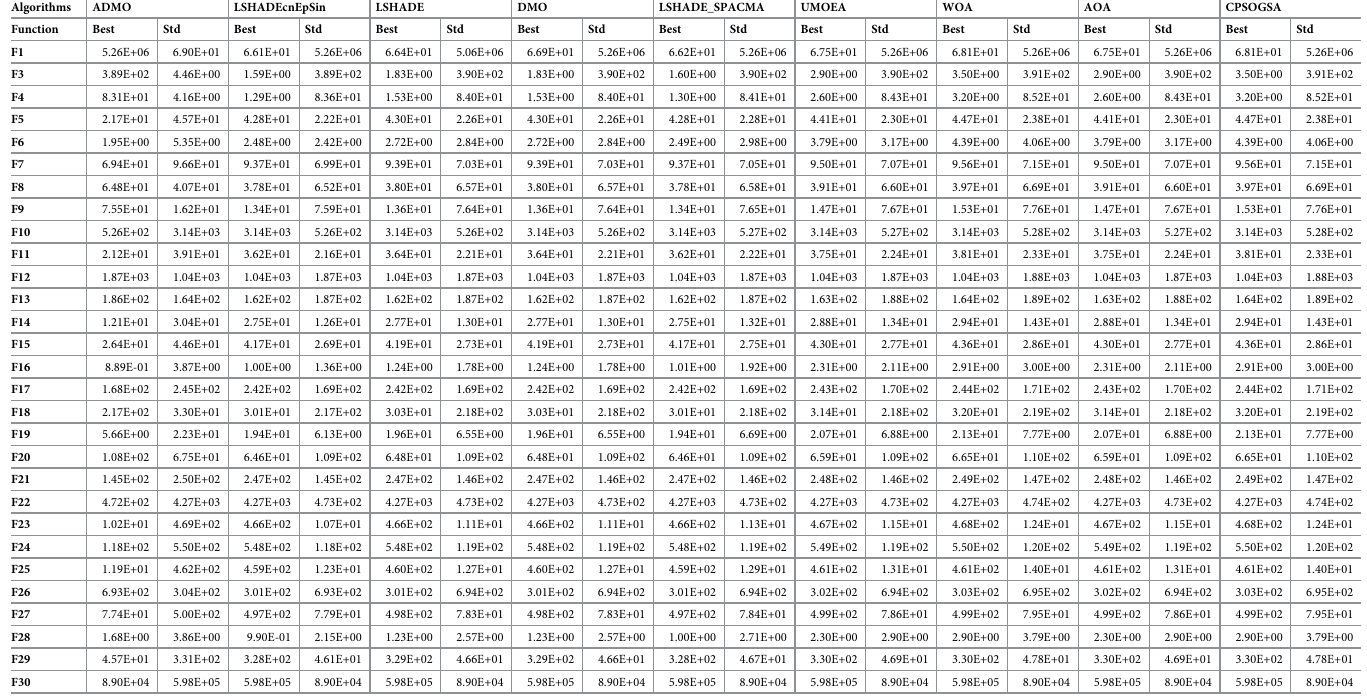
Table 13. Comparative results for 100 dimensions. Algorithms